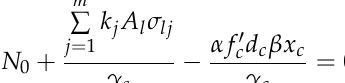
where k j is the number of the j th row longitudinal rebar; γ s is the partial safety factor of rebar; γ c is the partial safety factor of concrete; N 0 is the axial load; A l is the cross-sectional area of longitudinal rebar; f c (cid:48) is the concrete strength; and α and β are the two factors used to determine the equivalent rectangular stress